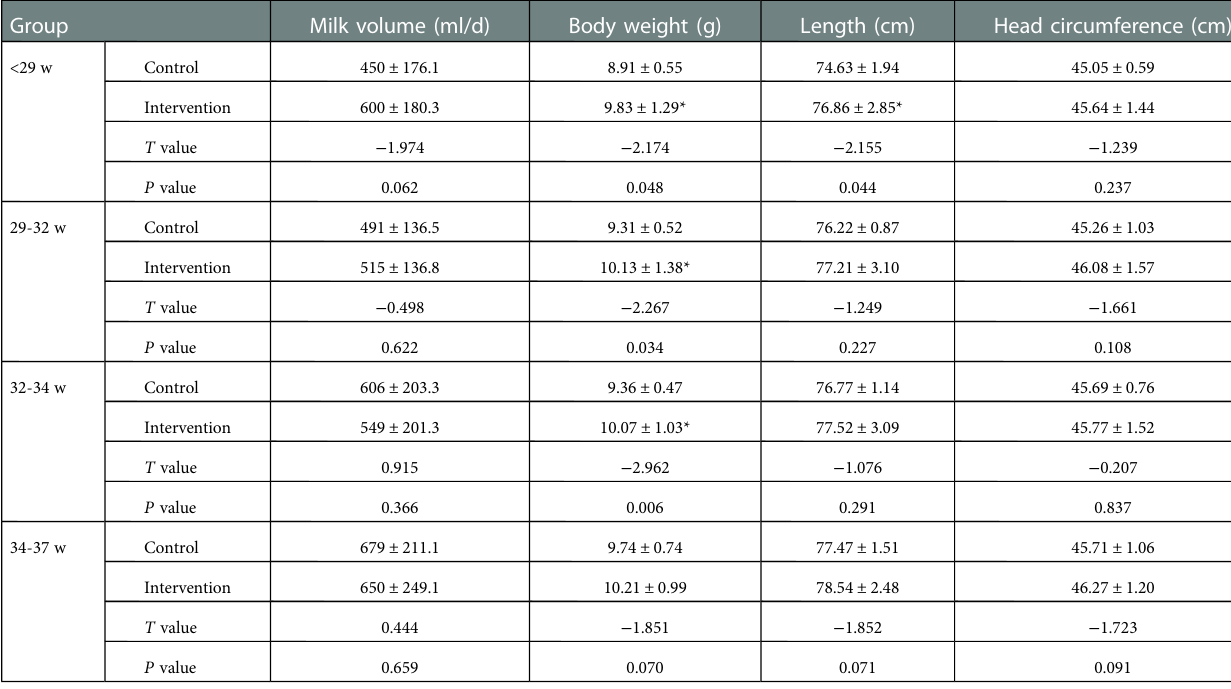
TABLE 6 Comparison of physical development of preterm infants with different gestational ages at 12 months corrected age. Group Milk volume (ml/d) Body weight (g) Length (cm) Head circumference